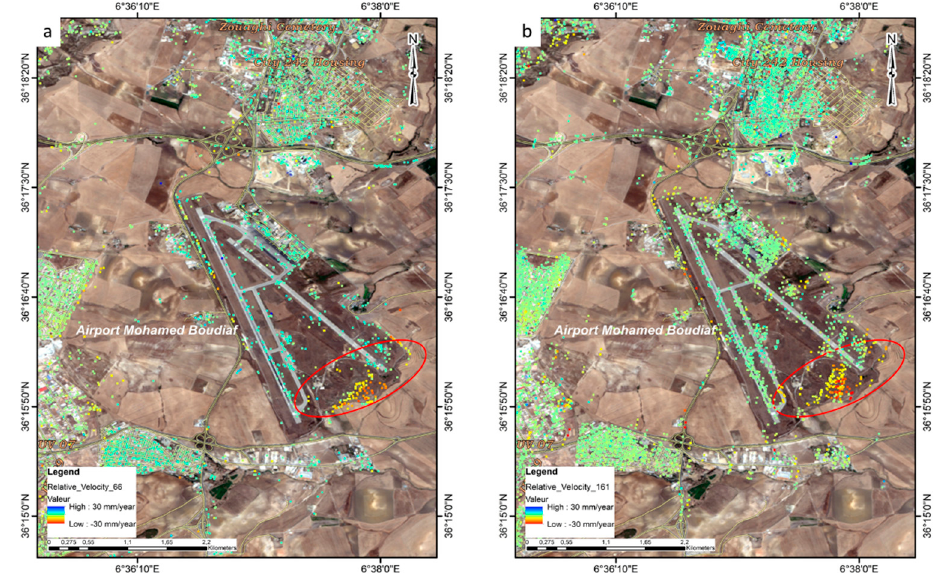
Figure 11. Deformation map at the Constantine airport; ( a ) descending orbit number 66; ( b ) ascending orbit number 161.